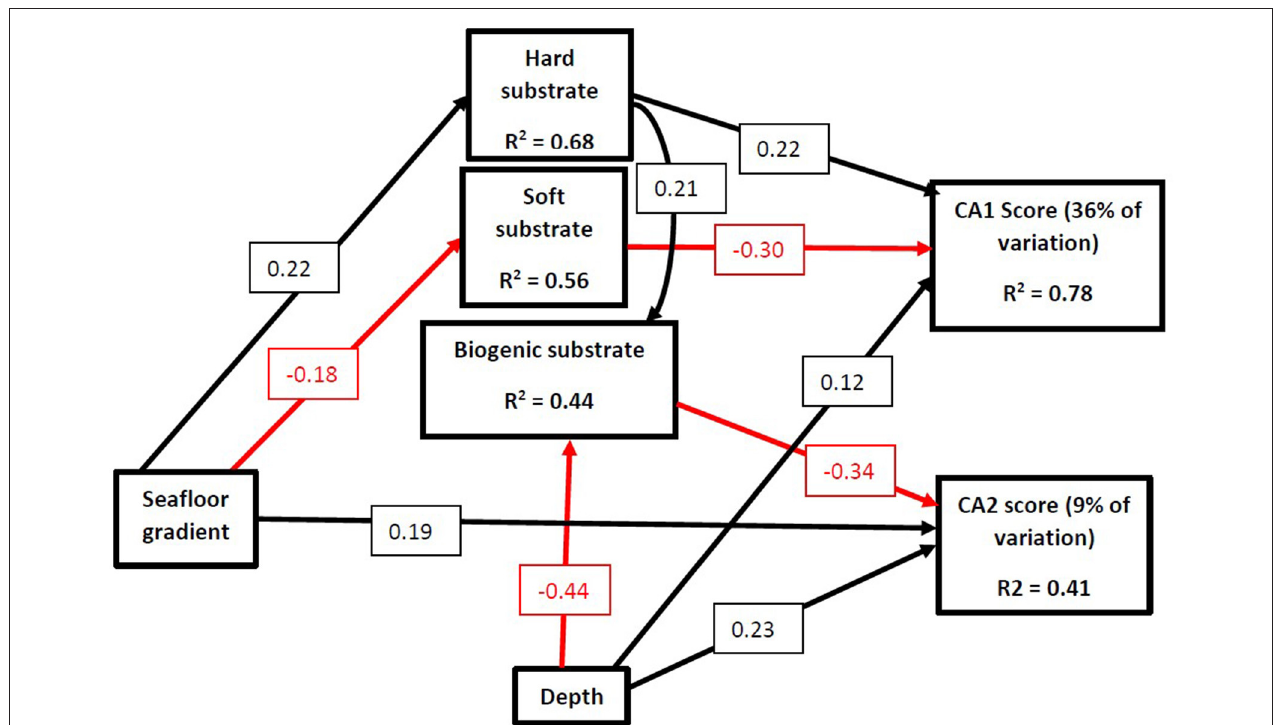
FIGURE 7 | Structural equational model (SEM) exploring the relationships between seafloor gradient, depth, substrate cover, and community structure as measured by CA1 and CA2 axis scores. Arrows represent unidirectional relationships among variables, with black arrows denoting positive relationships and red arrows depicting negative ones. Only significant pathways ( P ≤ 0.05) are displayed. The standardized regression coefficient is given in the associated box. R 2 s for component models are given in the boxes of the response variable. Model incorporates random effect of Region. Hard substrate represents the combined cover of gravel, cobbles, pebbles, boulders, and bedrock. Soft substrate represents the combined cover of sand and